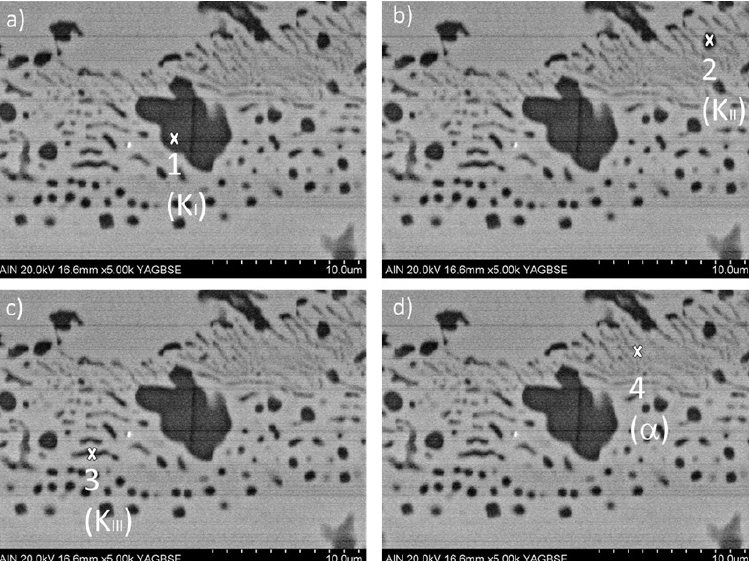
Figure 2. Backscattered electron (BSE) micrographs of the NAB alloy A with the presence of the different Kappa intermetallic compounds with their corresponding morphology such as rosette (a), spheroidal (b), lamellar (c) and alpha phase (d) with their area locations used in the EDX compositional chemical analysis for NAB alloy